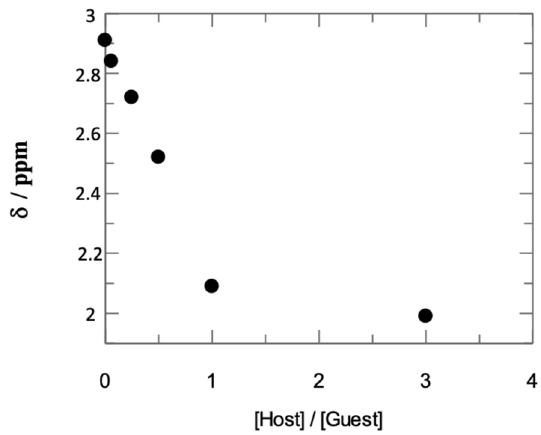
Figure 2. Chemical shifts for hydrogen atoms in alpha position to the sulfonate group in octylsulfonate in the presence of increasing concentrations of host.